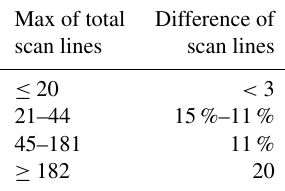
Table 1. Hanesch 2DVD scan line criteria.